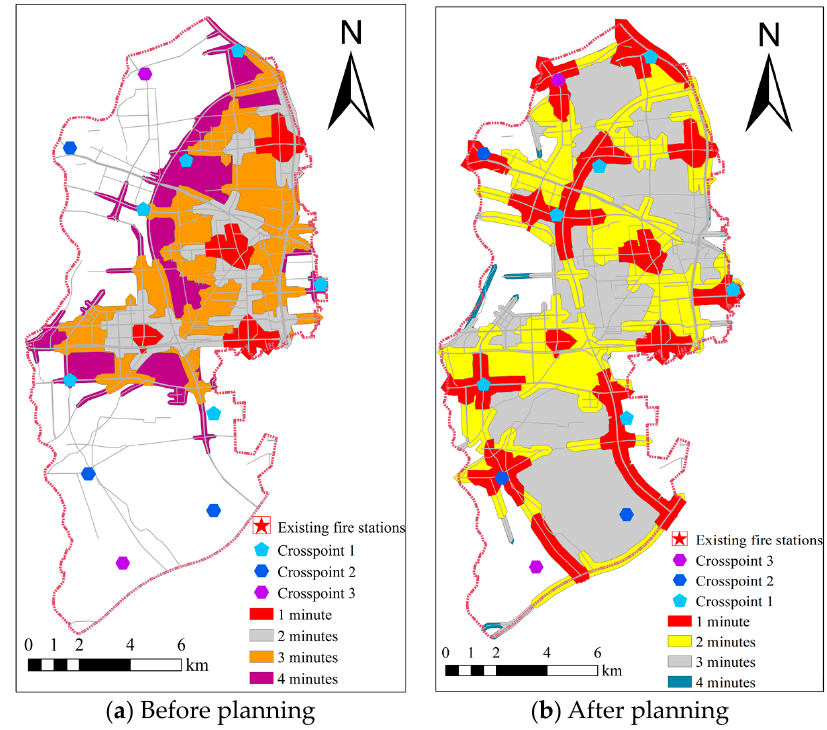
Figure 11. Area coverage in di ff erent time periods. Table 5. Coverage of POIs in di ff erent time periods before and after planning.